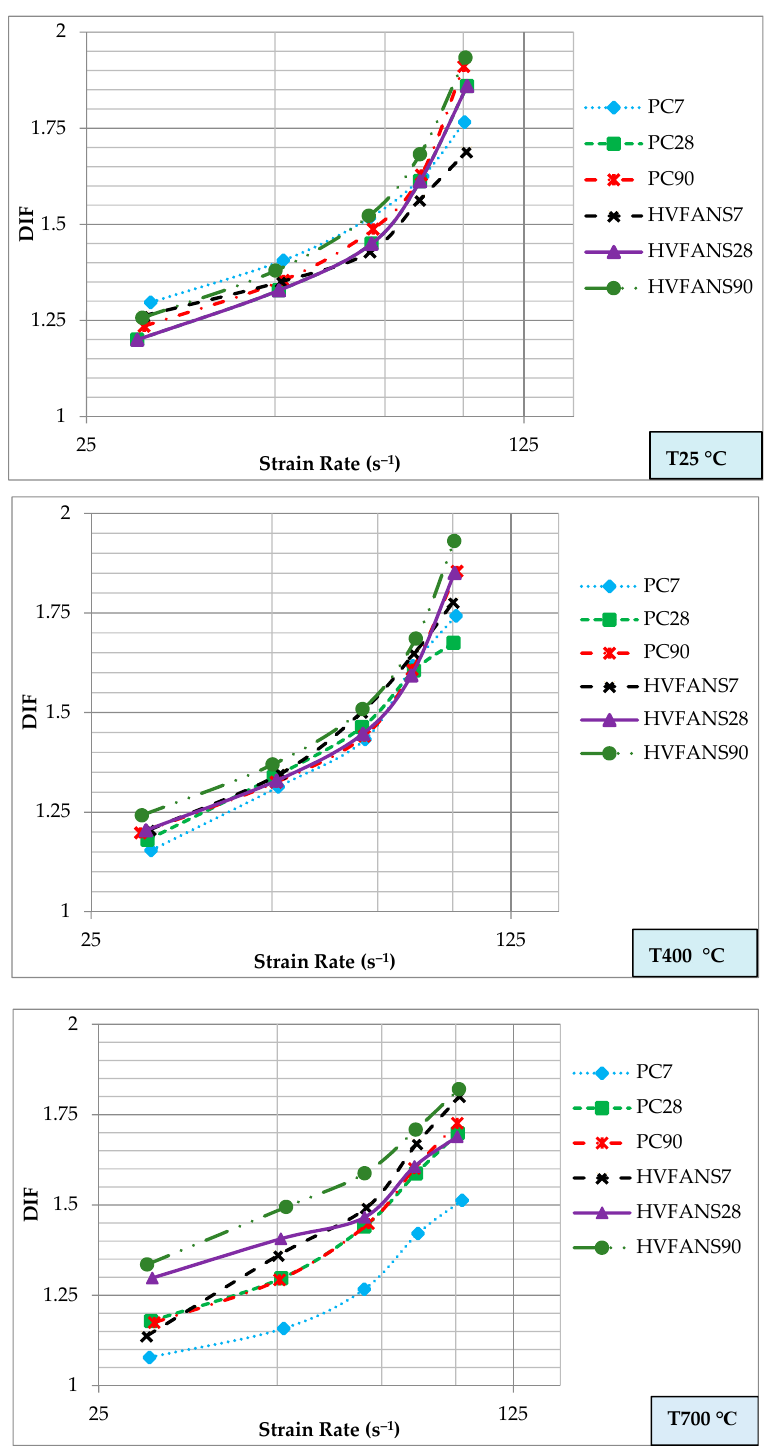
Figure 11. Effect of curing age on the dynamic increase factor (DIF) of concrete specimens at different temperatures and strain rates.